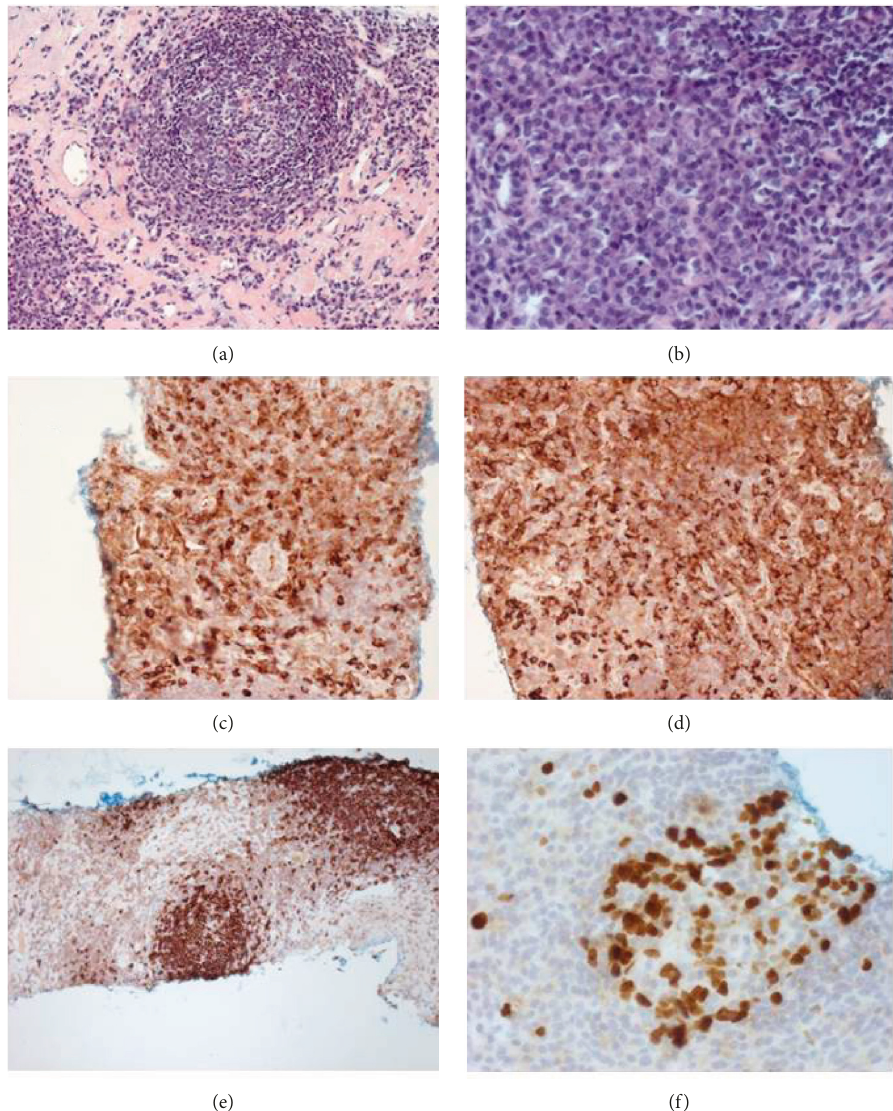
Figure 2: Histopathological appearances of the tumour. (a, b) Lymphoproliferative lesion was composed of dense infiltrates of mature lymphocytes and sporadic plasma cells along with lymphoid follicles with germinal centers. (a) Hematoxylin-eosin (H&E), × 10. (b) H&E, × 40. (c, d):Immunohistochemical (IHC) staining for immunoglobulin (Ig) ĸ (c) and Ig λ . (d) Light chains revealed polyclonal reactivity ( × 40). (e) IHC staining using CD20 antibodies showed high densities of B cells in reactive follicles. (f) Ki-67 IHC staining revealed high proliferative activity in the germinal center with no evidence of